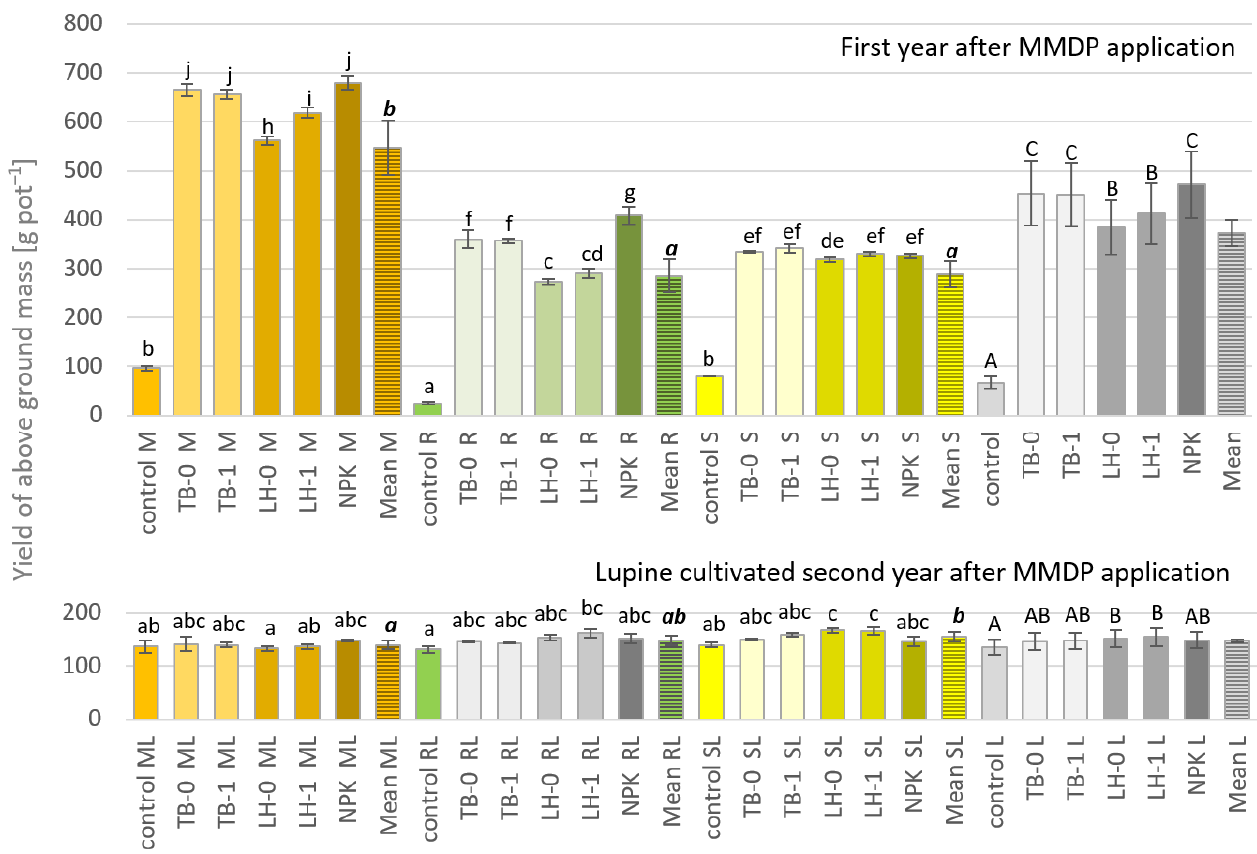
Figure 2. The aboveground yield of tested plants first year and second year after PM application. Values are means, error bars indicate the standard error (SE) of the means; means followed by the LSD p ≤ 0.05 test (uppercase—the differences between fertilizers used, lowercase italic—the differences between plant reactions, lowercase regular—the interaction fertilization vs. the plant − soil reaction); M − Maize, R—Rapeseed forage S—Sunflower, ML—Maize-Lupine, RL—Rapeseed Forage-Lupine, SL − Sun fl ower-Lupine; n = 3.